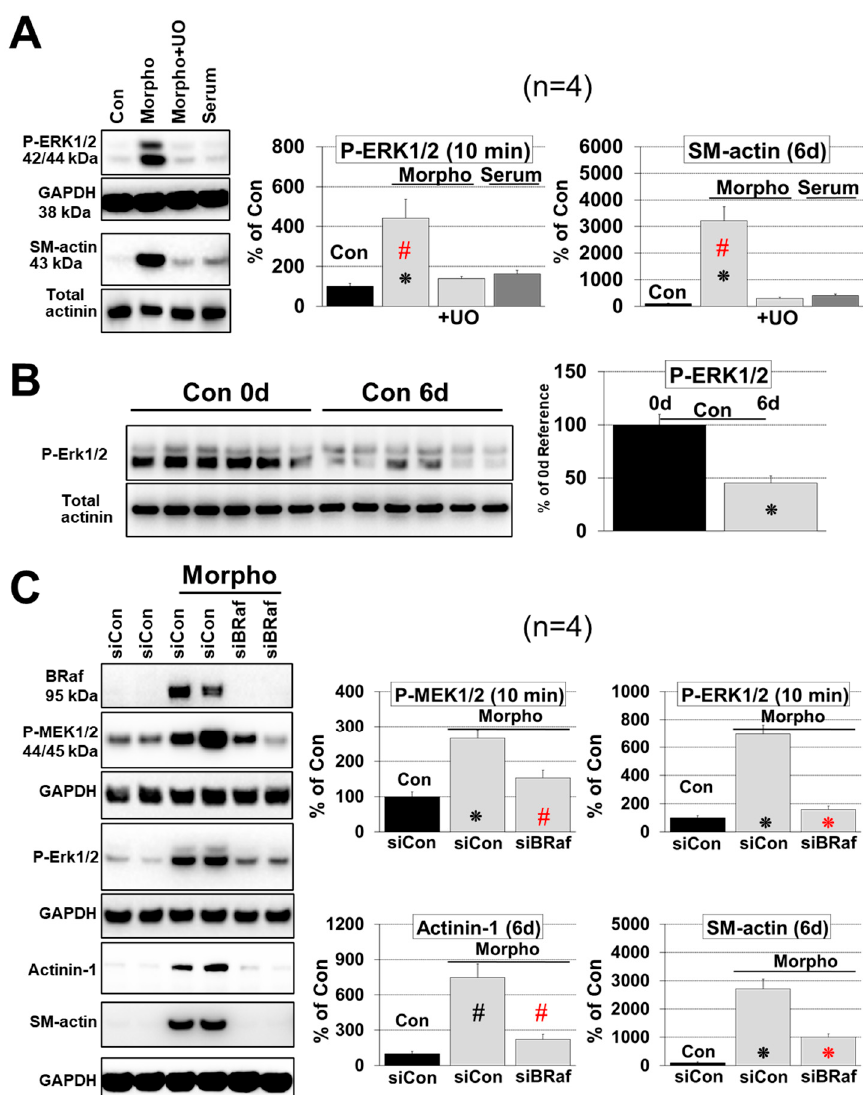
Figure 4. Knock-down of B-Raf and treatment with UO126 ( + UO) abrogates MAPK cascade activation and fetal remodeling. Isolated cardiomyocytes ( n = 4) were allowed to recover for 1 day (Con 0 d) and then treated for 10 min (10 min) or 6 days (6 d) for western blot analysis. Cultures were treated with basic medium (Con), with serum (Serum), or with morphogens (Morpho) as indicated. MEK1 / 2 inhibitor UO126 (UO, 5 µ M) was added 1 h before the experimental start as indicated. Quantitative evaluation and statistical analysis of western blots (WB) are shown. Single star and hash sign indicate p < 0.01 and p < 0.05, respectively. Black signs refer statistically to Con. Red signs compare Morpho (Morpho, Morpho siCon) statistically with and without UO / siB-Raf ( + UO, siBRaf). ( A ) WB analysis of ERK1 / 2 (P-ERK1 / 2) activation and dedi ff erentiation (SM-actin) in the absence or presence of UO ( + UO). ( B ) WB analysis of P-ERK1 / 2 of untreated cardiomyocytes (cultured in basic medium) at 0 d and after 6 d ( n = 6). ( C ) After a three-day pretreatment period with siRNA, cardiomyocytes were cultured in basic medium or stimulated with Serum and Morpho for WB of α -actinin-1 (Actinin-1) and α -smooth muscle actin (SM-actin) for six days. In order to determine MEK1 / 2 and ERK1 / 2 phosphorylation (P-MEK1 / 2, P-ERK1 / 2) cultures were made quiescent after six days for one day in basic medium and then treated as indicated for 10